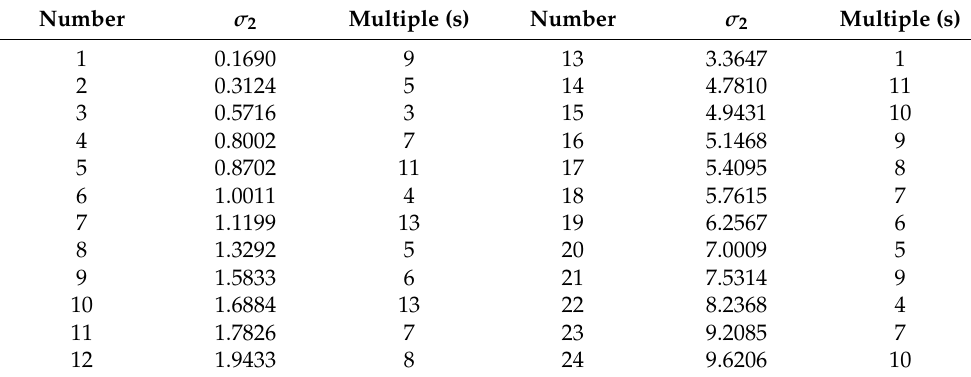
Table 1. Multiples of periodic motion with parameter σ 2 .